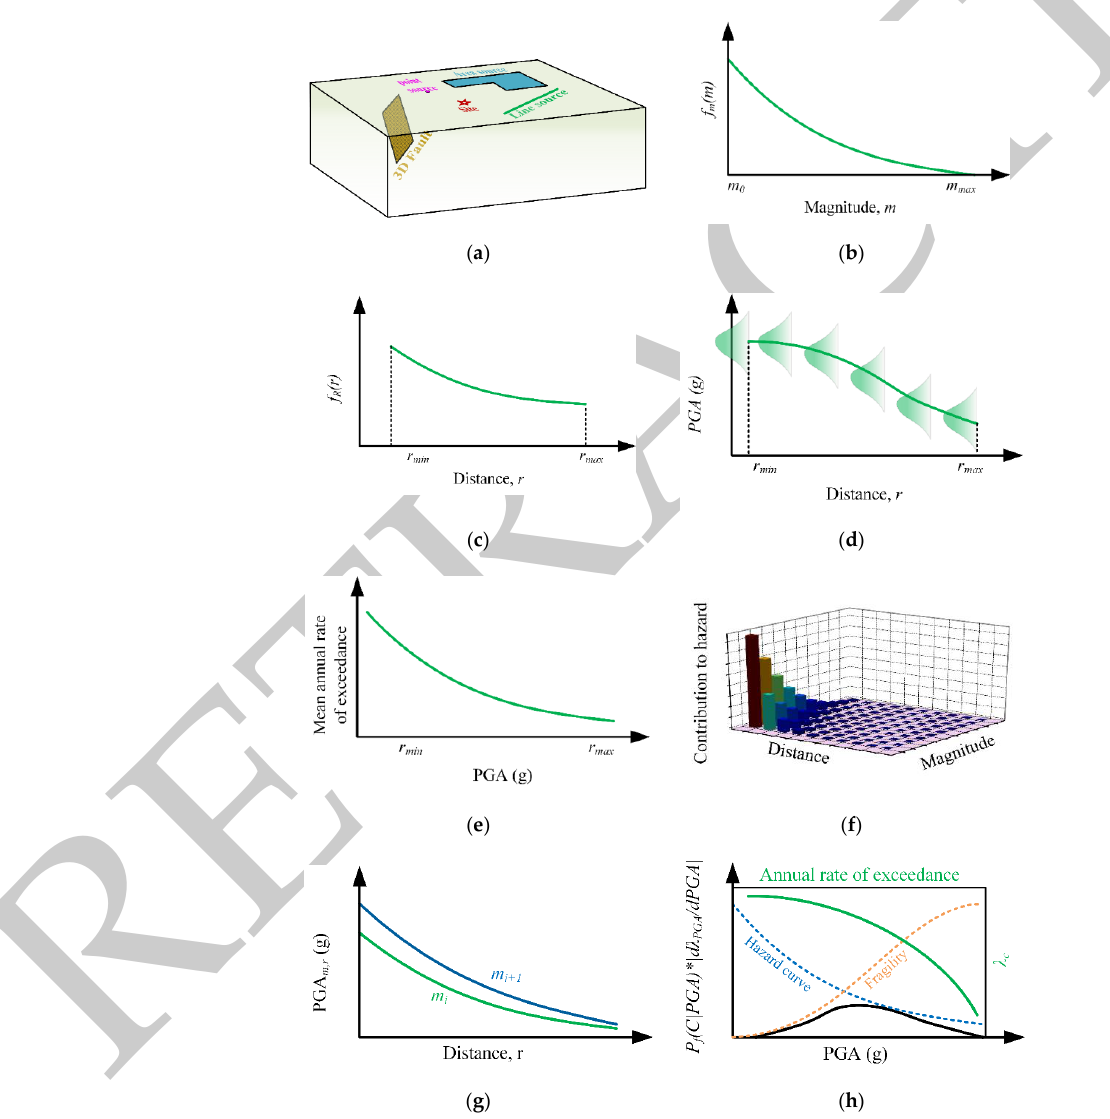
Figure 1. Schematic illustration of the basic steps for the analysis by PSHRisk-tool: ( a ) Earthquake sources identification, ( b ) Earthquake magnitudes distribution from each source, ( c ) Distribution of source-to-site distances, ( d ) Attenuation relation, ( e ) Combination of parts a-d to compute the seismic hazard curve, ( f ) EPSHA analysis, ( g ) GMPE plotting for specific source-site, ( h ) Failure risk